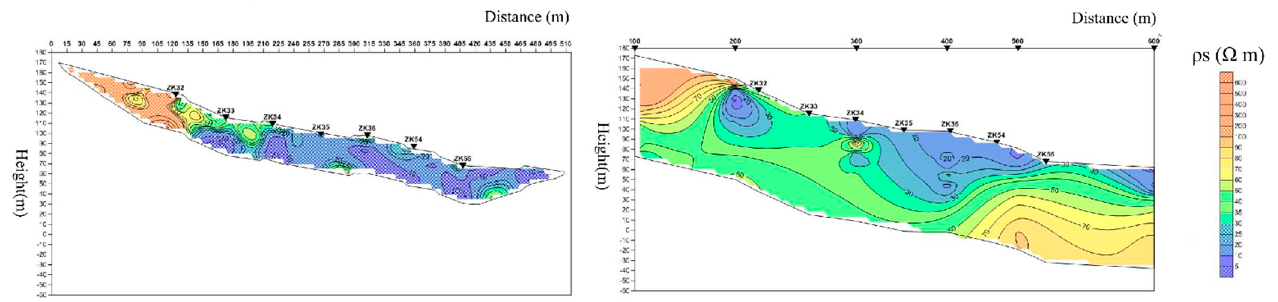
Figure 9. Geophysical section of 2 − 2.